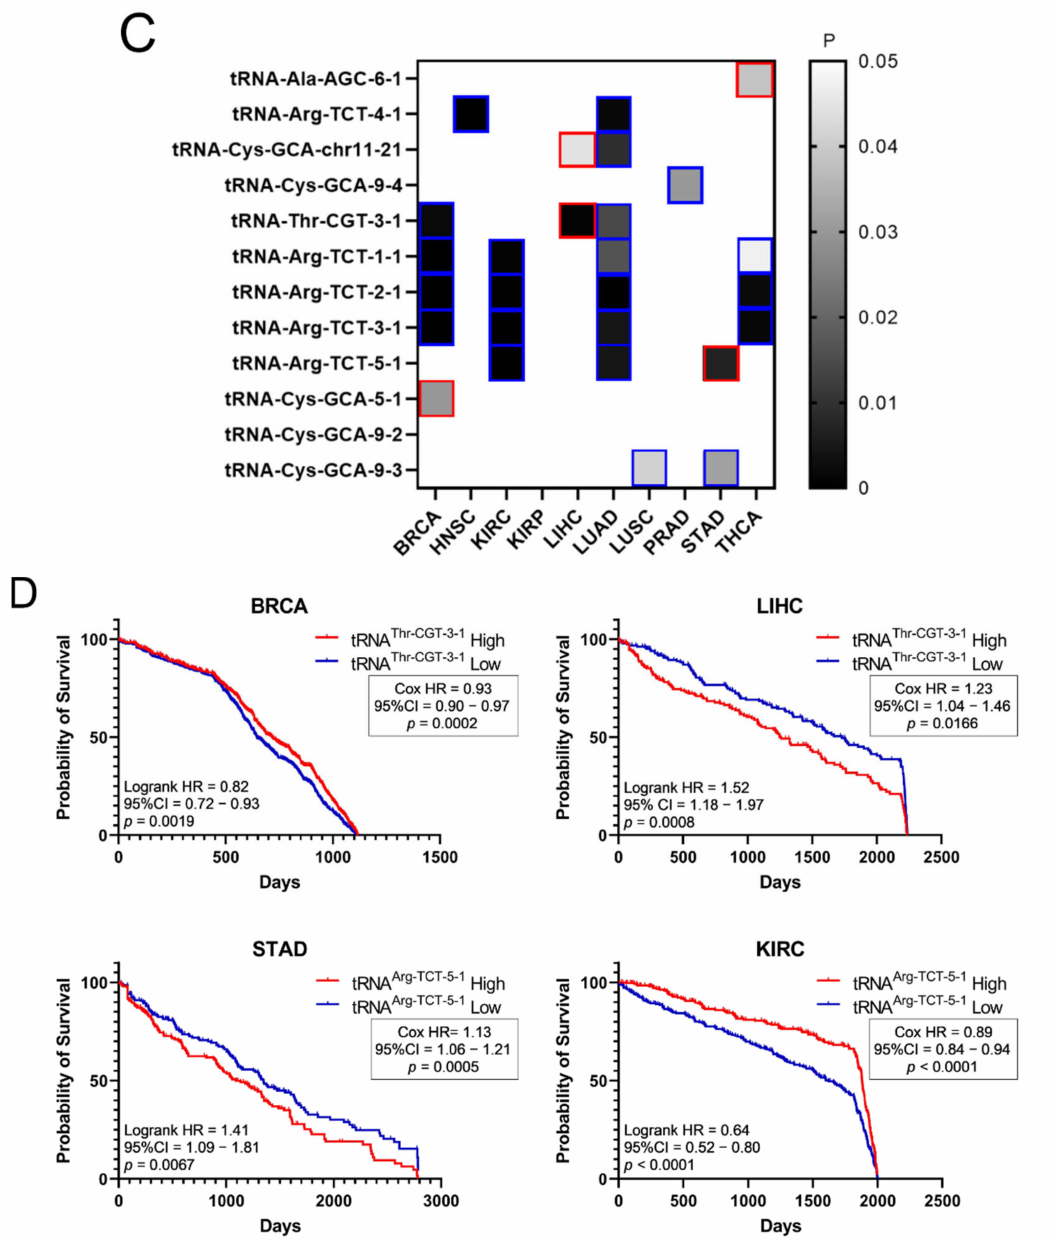
Figure 7. tRNA isoacceptor expression. ( A ) common tRNA isoacceptor upregulation (FC > 2, p < 0.05 and q < 0.05) in different TCGA cancers. The p -values were calculated with the two-tail, unequal variance t -test. ( B ) Most common upregulated tRNA isoacceptors. The fold change (FC) shows upregulation in the tumour (5170) vs. the normal (553) samples in all datasets. The p -values were calculated with the unpaired, two-tail, unequal variance t -test. ( C ) Patient survival p -values in tumours with upregulated (red outlines) or downregulated (blue outlines) tRNA isoacceptor expression that correlated with worse patient survival. The grey squares represent p < 0.05 and q < 0.05. ( D ) Indicative Kaplan–Meier survival plots of patients with tumours presenting upregulated or downregulated tRNA isoacceptor